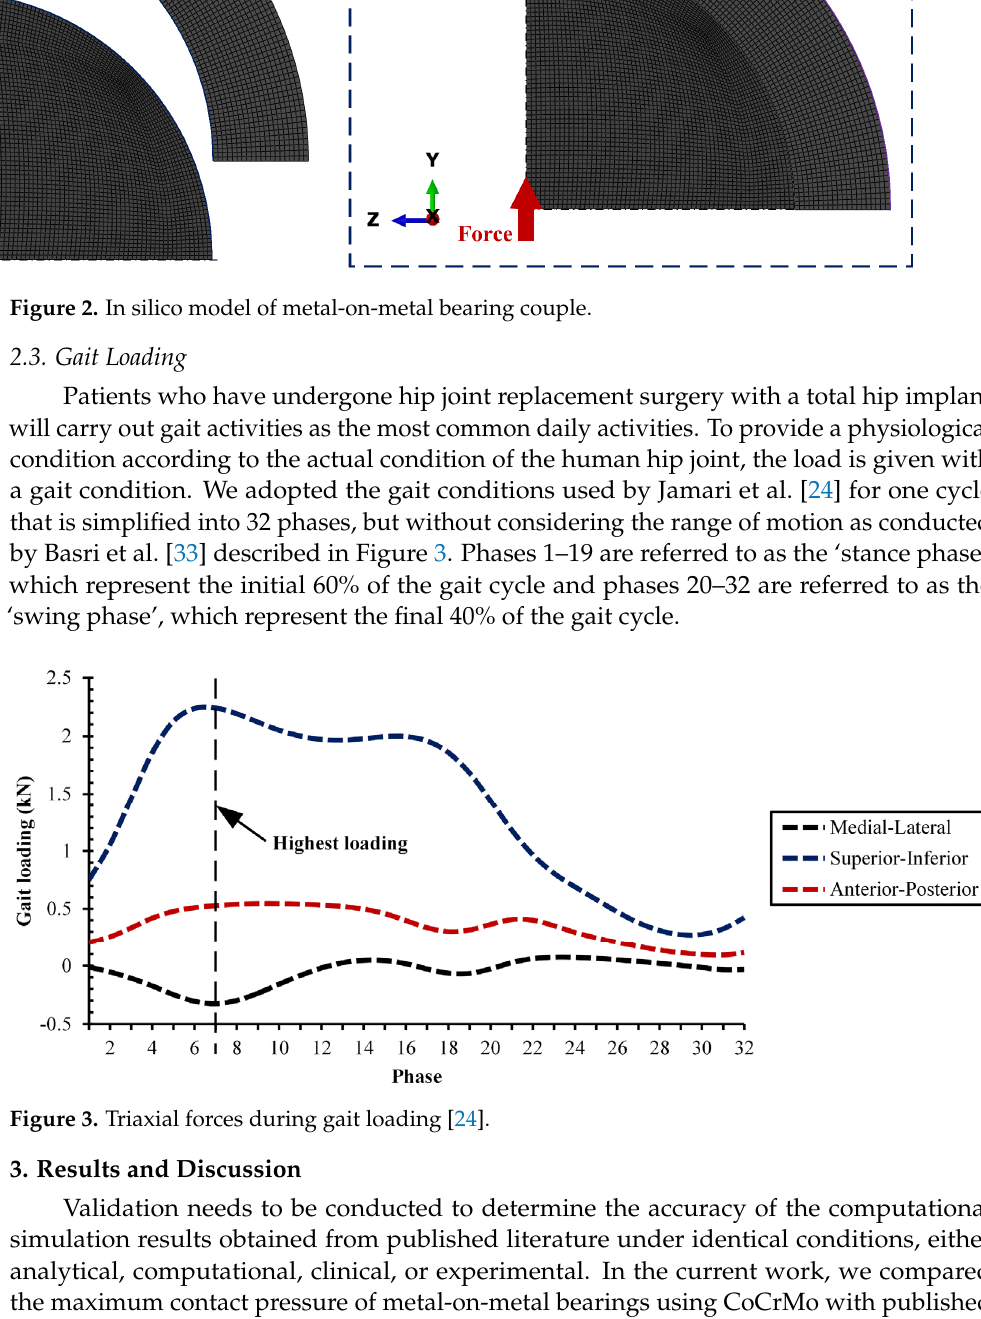
Figure 3. Triaxial forces during gait loading